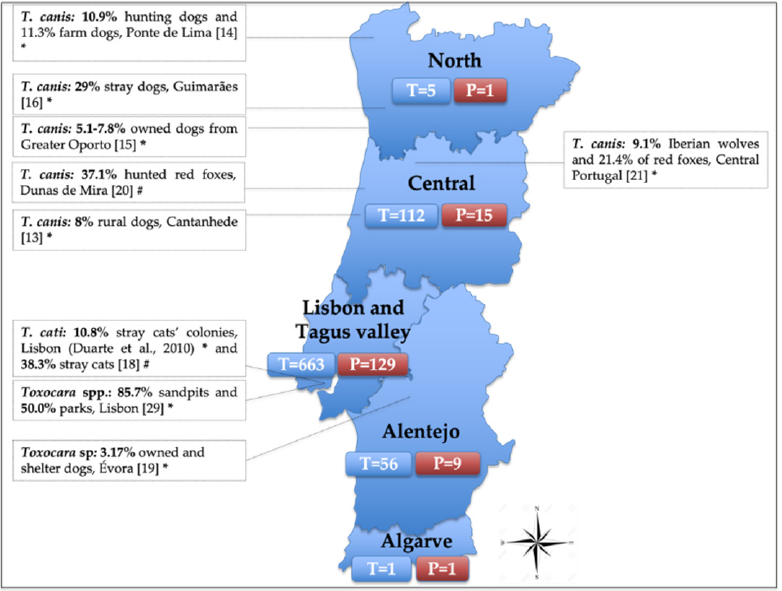
Figure 3. Distribution of the tested (T) and positive (P) human samples for Toxocara spp., received at the Institute of Hygiene and Tropical Medicine (IHMT) from 2010 to 2020, divided by its provenance according to the five regional health units of continental Portugal. T = number of tested samples (nine samples are not shown in the figure as provenance is unknown); P = number of positive samples (four positives are not shown in the figure as provenance is unknown). The side text boxes show the epidemiological studies conducted to assess Toxocara prevalence in soil and in animal species in Portugal. * Samples tested by coprological analysis; # Samples tested by parasitological necropsy. In our study, exposure to Toxocara spp. was equally common in females and males, in opposition with the bibliography that reports male sex as a potential risk factor asso- ciated with seropositivity to Toxocara spp. [26]. Additionally, 59.7% of the positives were diagnosed in children younger than 20 years, in line with the bibliography that reports toxocariasis as a predominant disease of children, given their pica behaviors and poor hand hygiene [26]. In a study conducted to assess parasite control practices in owned pets from Lisbon (Portugal), although 89.7% of the dogs and 63.6% of the cats were being treated with endoparasitic drugs, merely 11.8% of the dogs and 5.5% of the cats were treated with the recommended regimen (minimum quarterly) [34,35]. This report showed that although the majority of pet owners give antiparasitic drugs, most of them do not follow the manufacturer’s recommendations, deworming at irregular and consequently ineffective intervals [35]. Therefore, periodic deworming of household pets, in general, should be promoted, especially puppies and kittens along with pregnant bitches/cats which are more prone to transmit the disease. Besides, as found by Matos et al., 2015 [35], 37% of Por- tuguese dog owners did not collect their dog’s feces in all public places, claiming several excuses: feces considered fertilizers (43.2%); feces located on abandoned/unreachable areas (37.7%); laziness/repulsiveness (14.5%) and shame (4.6%). Owners should safely collect and hygienically dispose of their pet’s feces, avoiding eggs becoming infective and consequently breaking the dog-soil-human transmission cycle of toxocariasis. Additionally, the lack of an effective anthelmintic method to kill Toxocara spp. eggs make it difficult to eradicate this parasite from the environment [36]. Taking into account the potential impact of not collecting feces and the potential zoonotic nature of some of the pathogens, this is regrettable and highlights the need for owner awareness to reduce environmental contamination pressure and safeguard public and animal health. Preventing